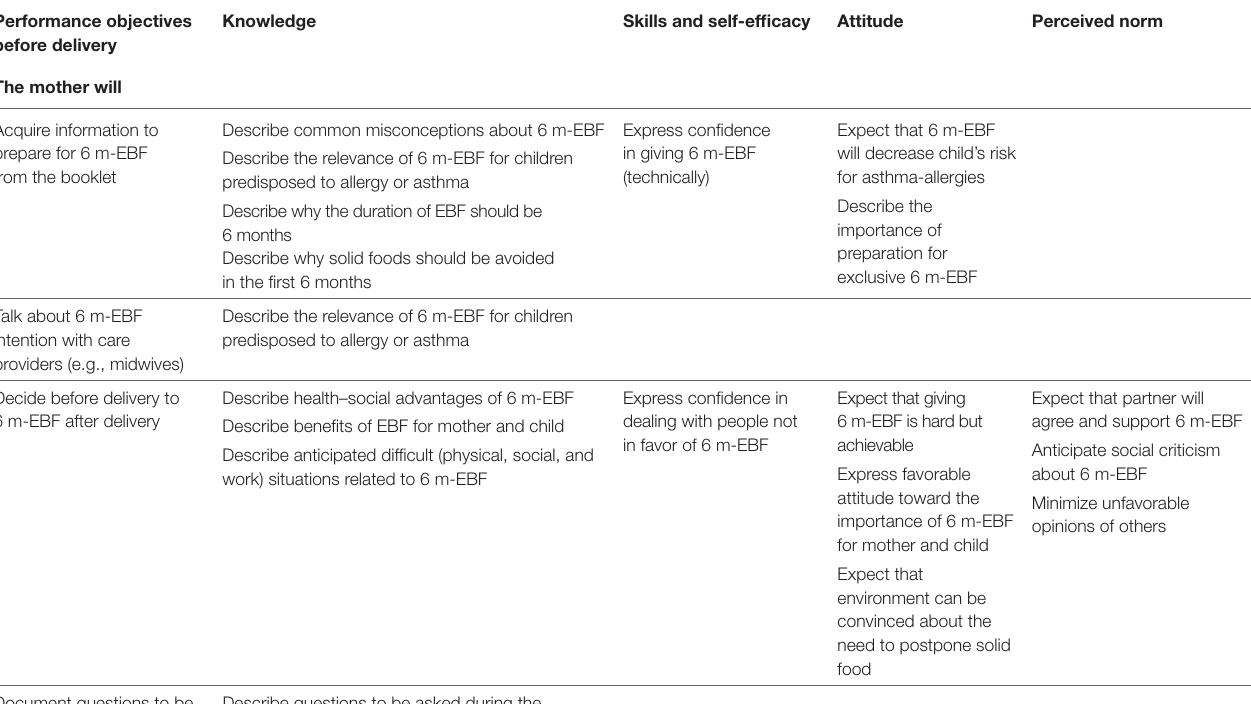
tABlE 1 | Partial matrix of change objectives for women that exclusively breastfeed for 6 months (6 m-EBF). Performance objectives before